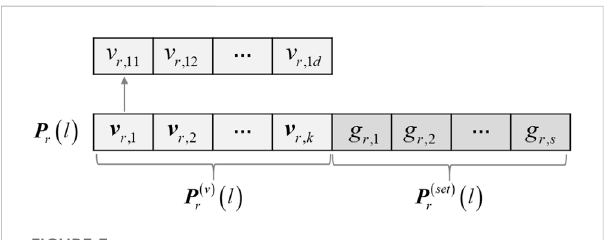
FIGURE 3 The mixed chromosome encoding strategy used in